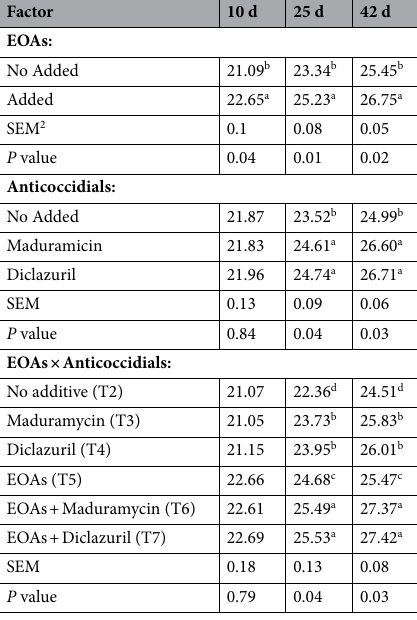
Table 6. Effect of EOAs and anticoccidials on jejunal GC 1 number of infected broilers in different ages. a–b In each column, means with no same (a, b) superscript differ significantly in p < 0.05 value. 1 GC: goblet cells. 2 Pooled standard error of